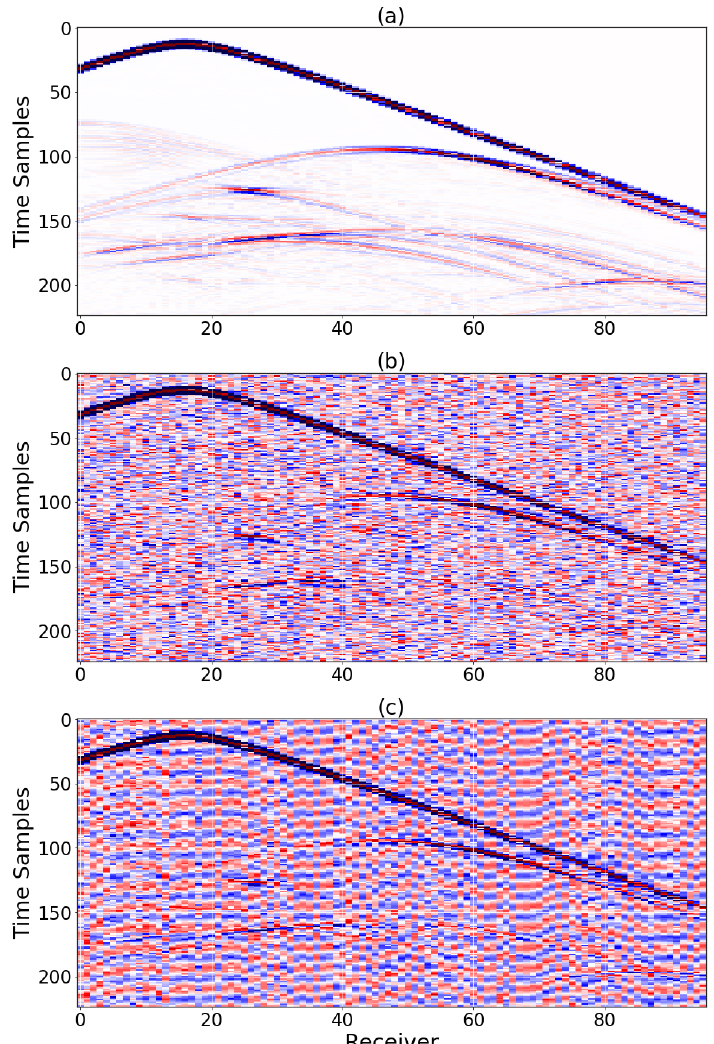
Figure 3. A 2D slice of a 3D shot-gather: ( a ) noiseless. ( b ) distorted by additive white Gaussian noise (SNR = 10 dB). ( c ) distorted by additive colored field noise (SNR = 10